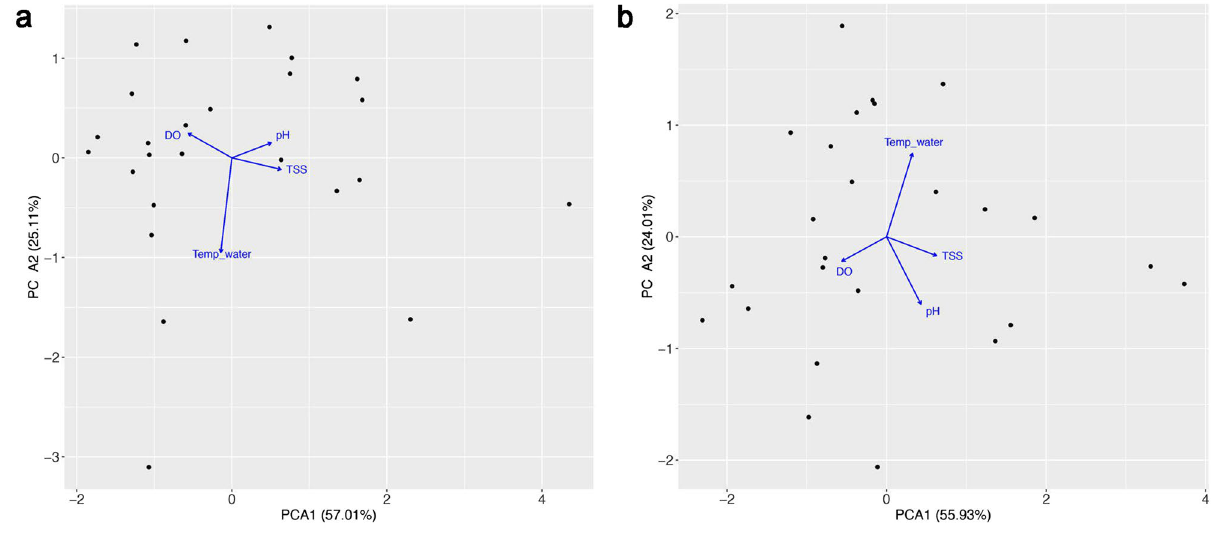
Figure 3. PCA of the limnological variables sampled in 25 sites in Manaus during the dry (a) and rainy (b) seasons. DO: dissolved oxygen; TEMP_WATER: water temperature; TSS: total suspended solids; Black points are sites.